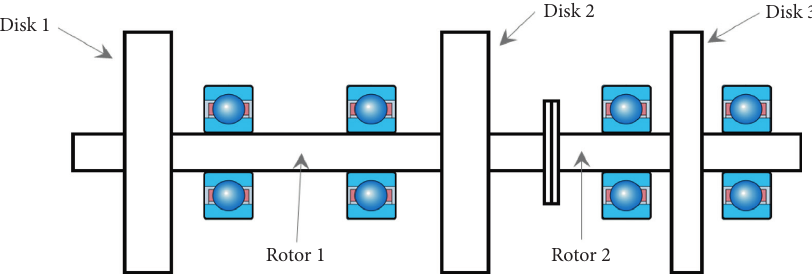
Figure 26: Wang and Gong‘s model [25]. Table 10: Data of the numerical model of Wang and Gong